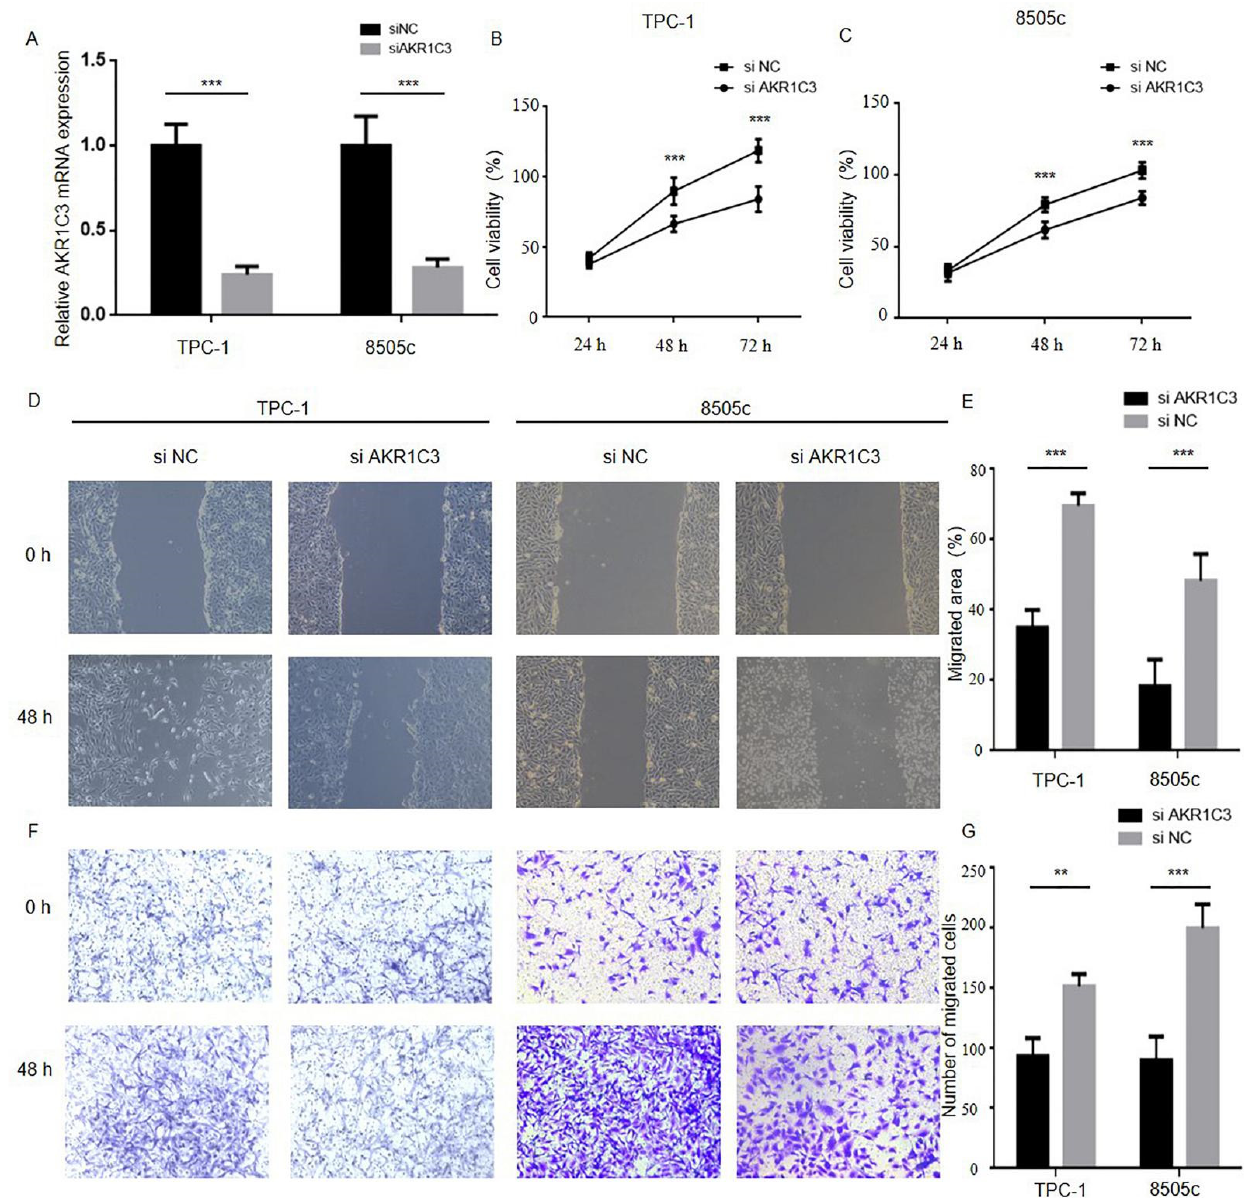
Figure 4. Reducing AKR1C3 expression in thyroid cancer cells inhibits proliferation, migration and invasion: ( A ) TPC-1 and 8505c cell lines were transfected with siNC or siAKR1C3, and the level of PHLPP1 mRNA expression was assessed by RT-qPCR; ( B , C ) the CCK-8 assays indicated that knockdown of AKR1C3 inhibits cells proliferation in TPC-1 and 8505c; ( D – G ) the wound-healing and transwell asssays suggested that AKR1C3 reduces cell migration and invasion in TPC-1 and 8505c (** p < 0.01, *** p < 0.001).